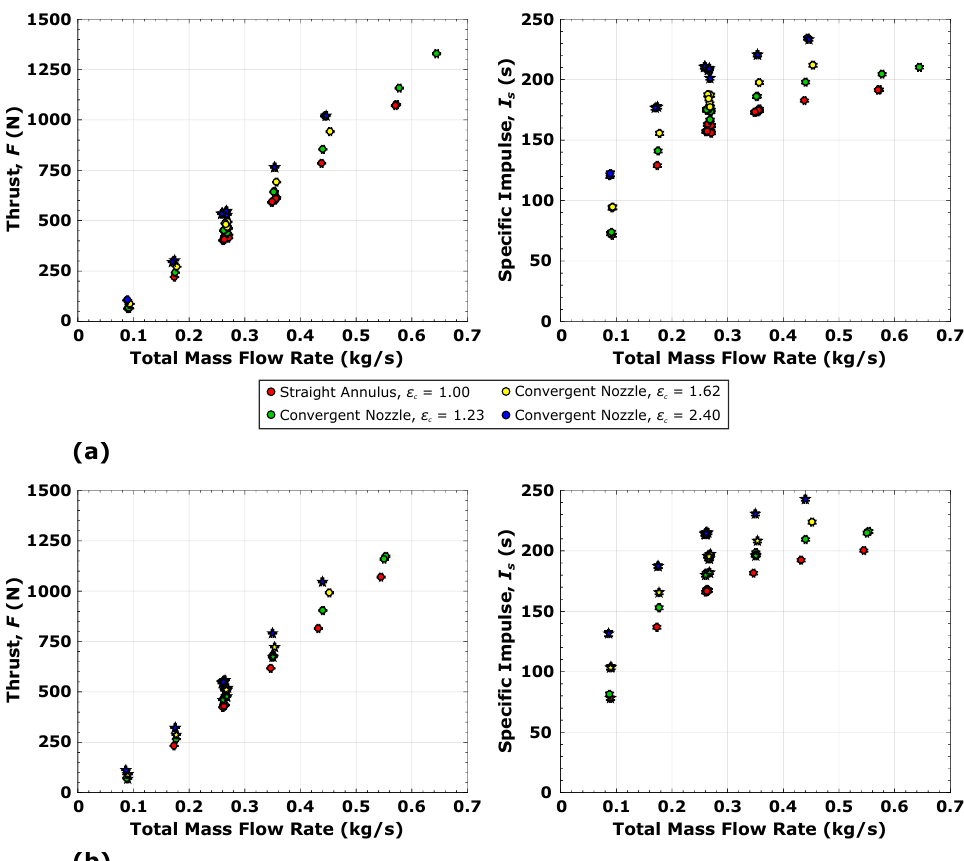
Figure 6. Performance summary for the l c = 76.2 mm convergent nozzle study showing thrust F and specific impulse I s for the total mass flow conditions at φ equaling ( a ) 1.15 and ( b ) 1.5, respectively. Depending on the flow condition and convergent nozzle geometry, the engine operates in either a corotating ( • ) or counter-propagating mode ( (cid:63)